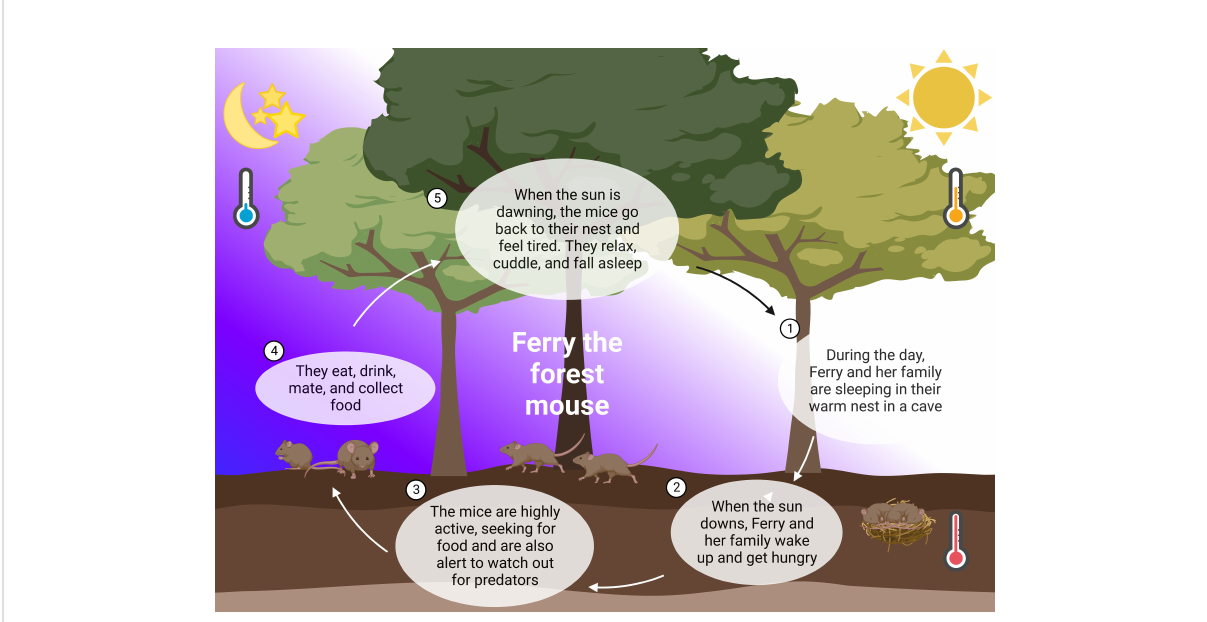
FIGURE 1 24 hours in the life of Ferry the forest mouse. In nature, mice follow their natural rhythm guided by abiotic zeitgebers such as light and temperature. They sleep during the day, cuddling in their warm nest in the soil ( 1 ). When the sun is downing, they wake up and leave the nest ( 2 ). The mice use the night and their highest alertness to seek for food and watch out for predators ( 3 ). A lot of running, climbing, and collecting of food during the night ( 4 ), releases them happily tired into the day and their sleep ( 5